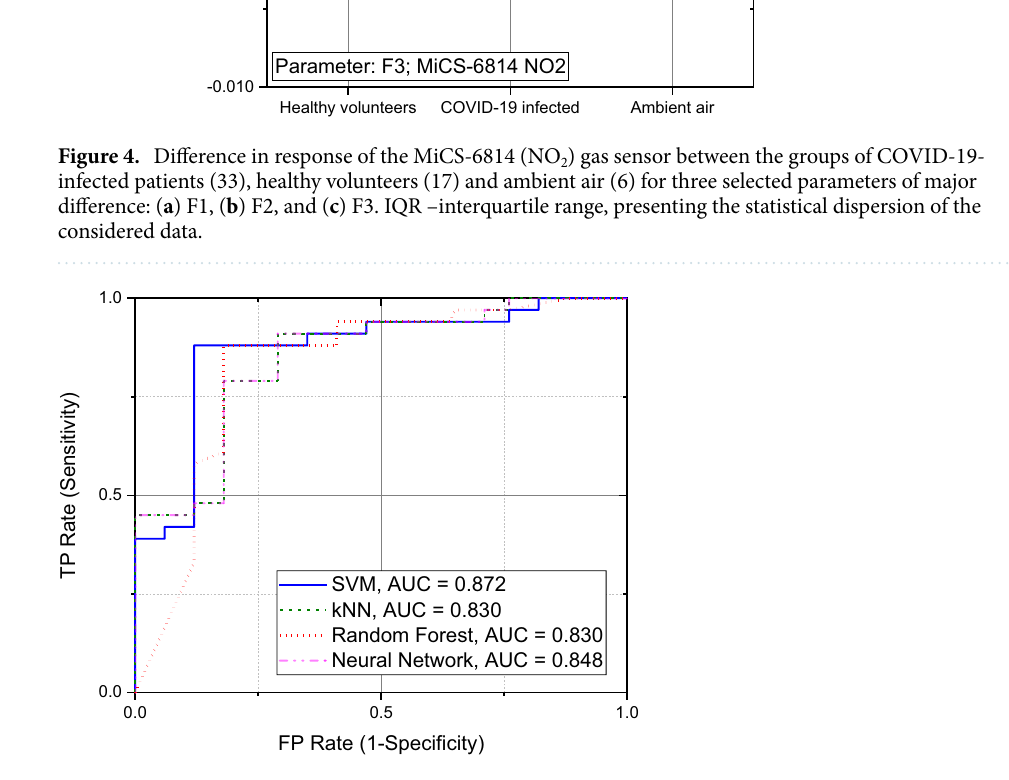
Figure 5. ROC curves observed for the examined cohort of 50 samples (33 COVID-19-infected patients, 17 healthy volunteers). Four selected detection algorithms were considered: SVM, kNN, Random Forest, Neural Network. AUC—Area Under the